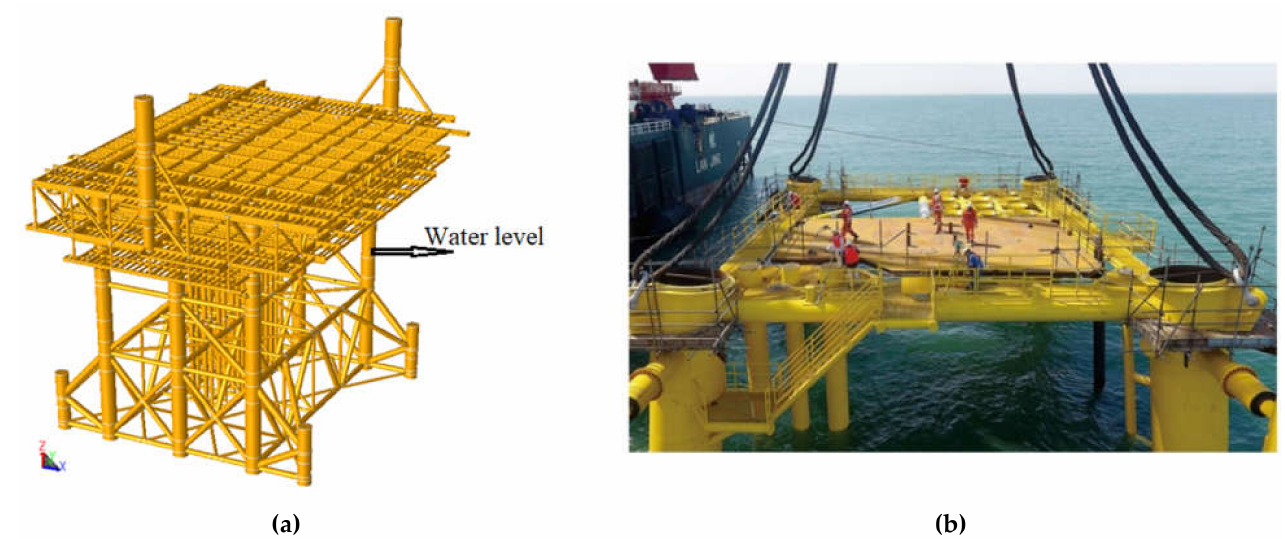
Figure 1. ( a ) Schematic diagram of JZ25-1S jacket; ( b ) real